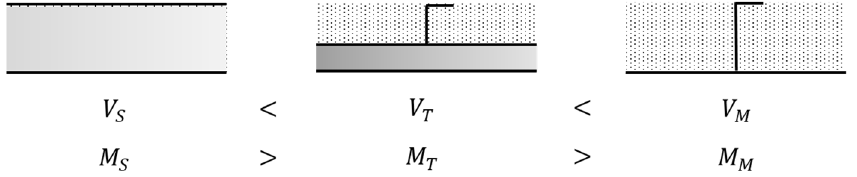
Figure 9. Comparison of the three structural concepts shows the order of mass ( 𝑀 (cid:3051) ) and volume occupied ( 𝑉 (cid:3051) ) where x = Sandwich ( S ), Stiffened sandwich ( T ) and metal grillage ( M ).